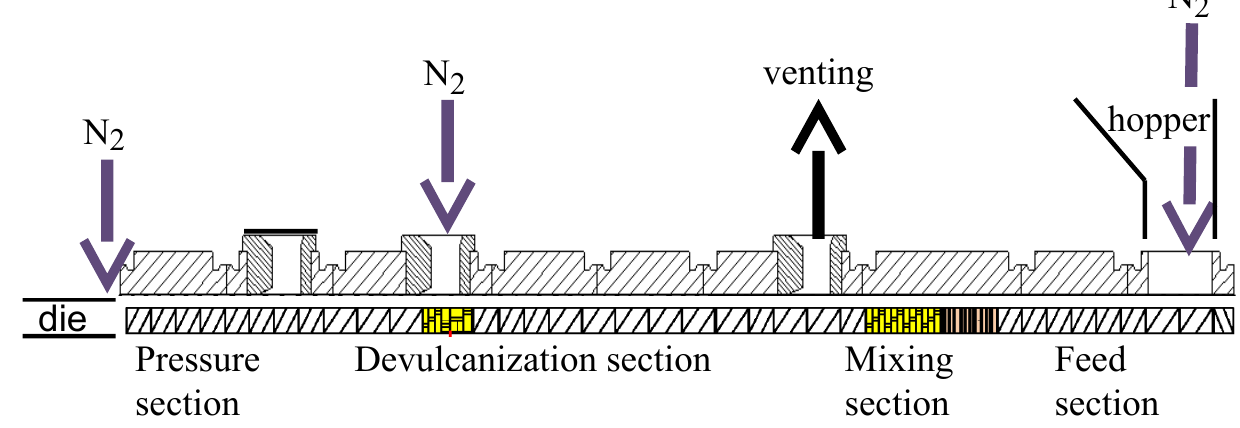
Figure 2. Layout of the extruder, from right to left, with an example of a screw with a limited amount of kneading and mixing elements after the mixing section, and nitrogen supply positions.